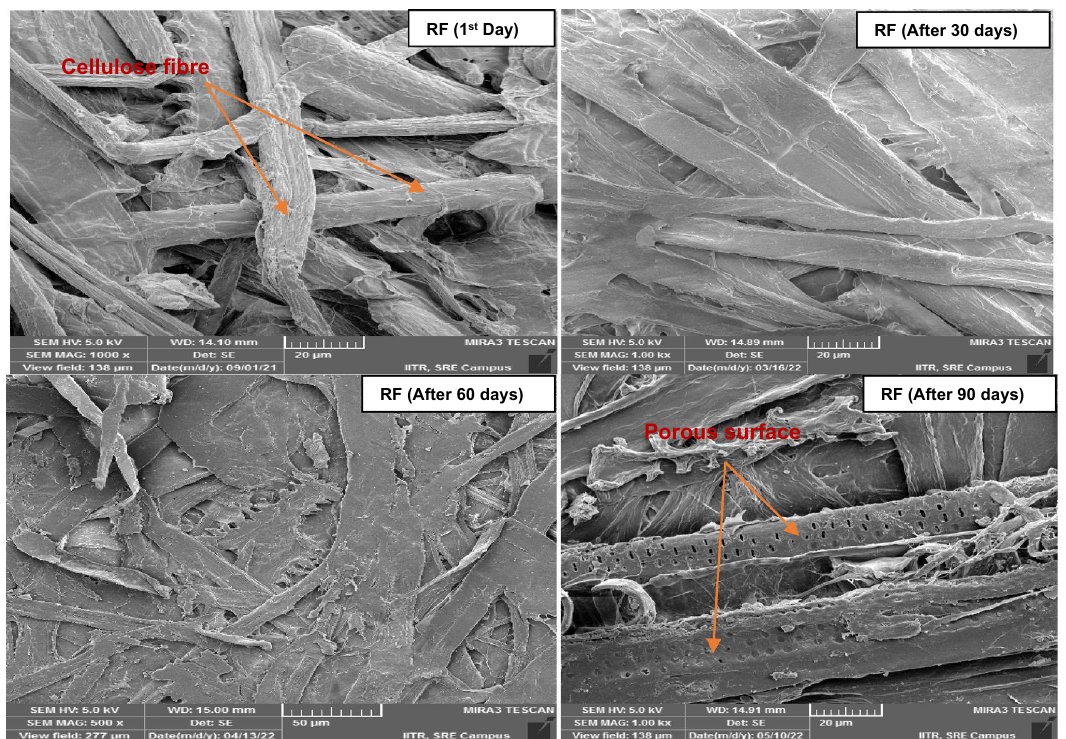
Figure 4. FE-SEM image analysis of the reference pulp